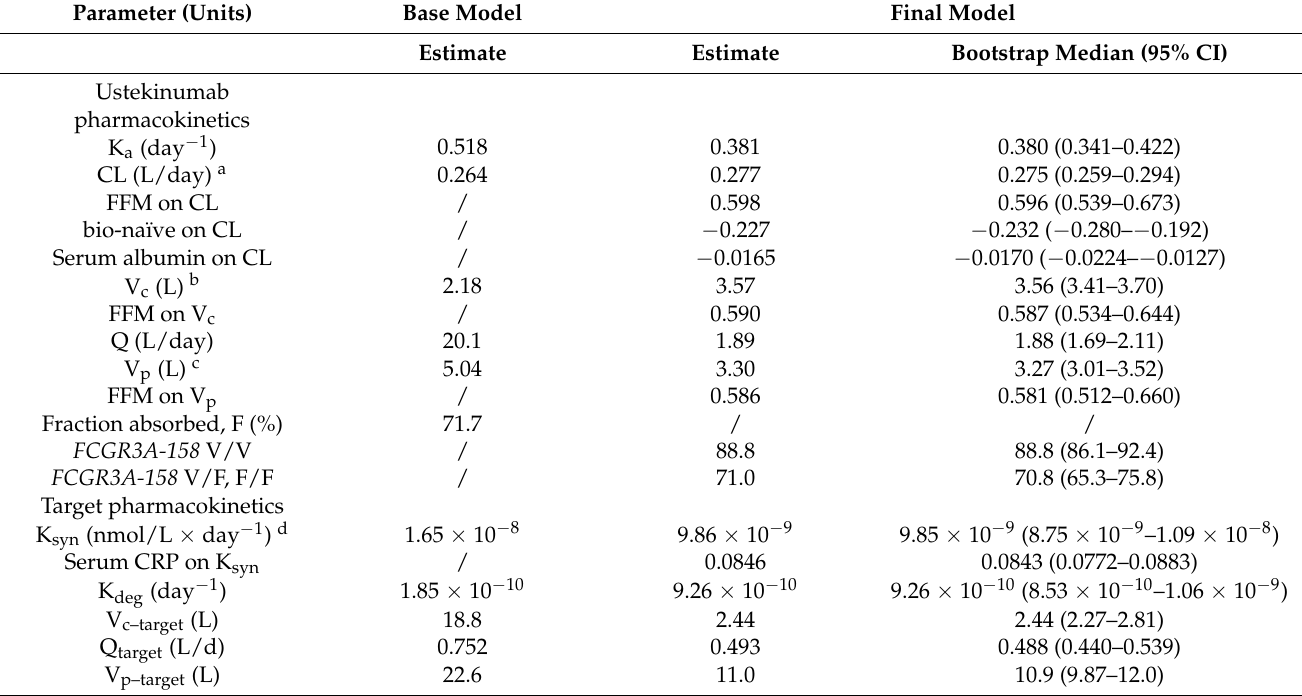
Table 2. Base and final pharmacokinetic model parameter